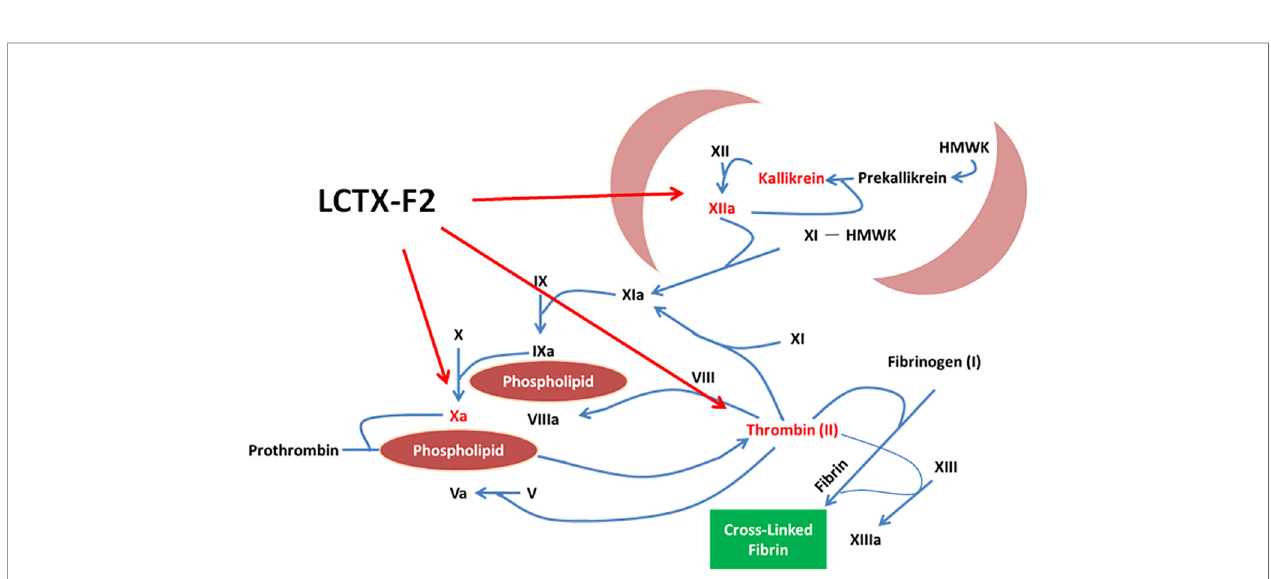
FIGURE 7 | LCTX-F2 promoted blood coagulation by increasing the activity of intrinsic blood coagulation factors, including FXIIa, kallikrein, thrombin, and